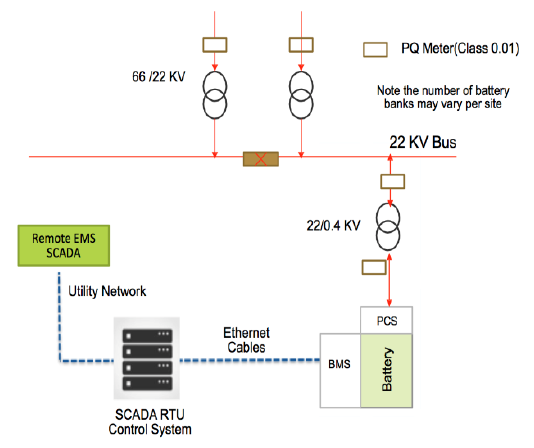
Figure 1. Typical Setup of a substation level Energy Storage System (ESS).